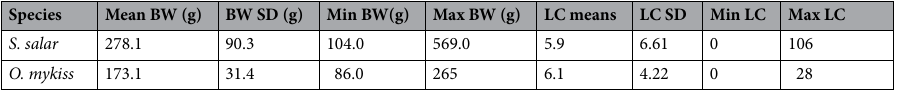
Table 1. Summary statistics for body weight (BW) and lice count (LC) in Atlantic salmon and rainbow trout. SD standard